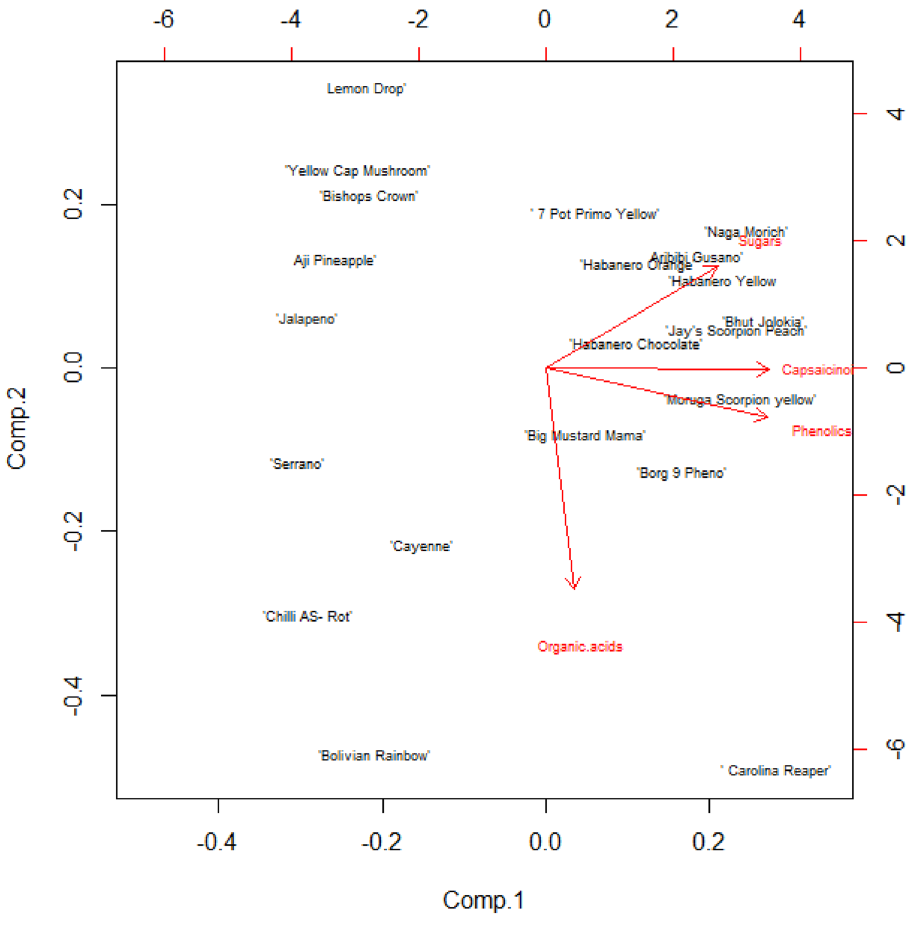
Figure 5. PCA analysis of all